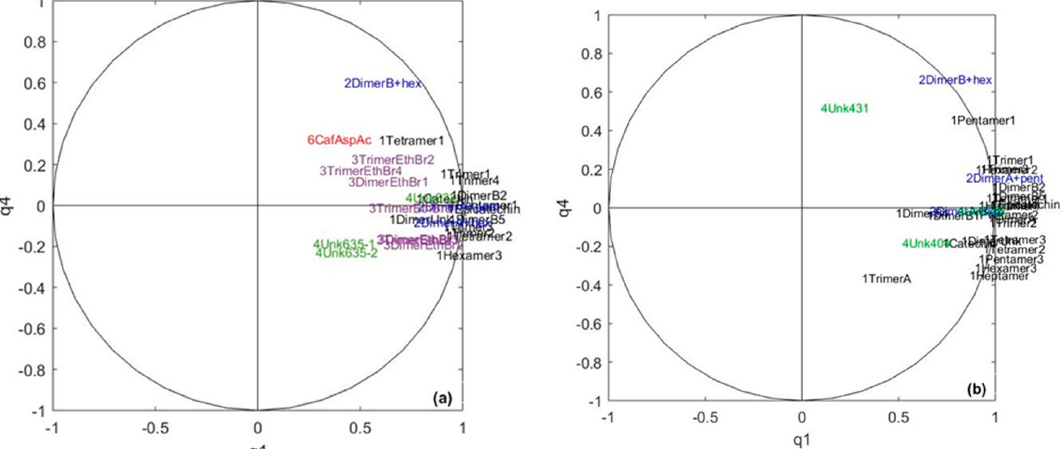
Figure 5. The CCSWA on the chocolate and cocoa data: ( a ) correlation circle in the common space for cocoa variables and ( b ) correlation circle in the common space for chocolate variables. Black = flavan-3-ols, blue = glycosylated flavan-3-ols, green = unknown compounds, red = hydroxycinnamic acid and purple = ethyl bridged flavan-3-ols.